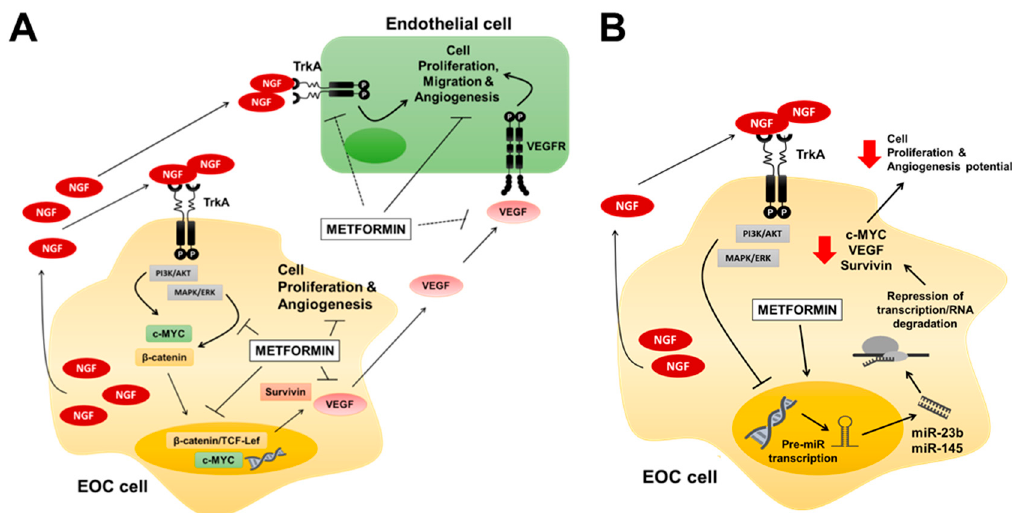
Figure 7. Proposed mechanisms by which metformin prevents NGF–mediated effects in EOC cells. ( A ) Metformin blocks the NGF-induced c-MYC, survivin and VEGF protein levels, decreasing the proliferative and angiogenic potential of EOC cells. NGF and VEGF are depicted as acting directly on endothelial cells, while c-MYC and survivin changes contribute to EOC cell proliferation and VEGF expression. ( B ) Metformin increases the expression of oncosuppressor miR-145 and miR-23b, which may be responsible for the observed decreases in c-MYC, survivin and VEGF levels in EOC cells. Filled arrows mean stimulation, thick perpendicular bars mean inhibition and dotted lines mean indirect association.